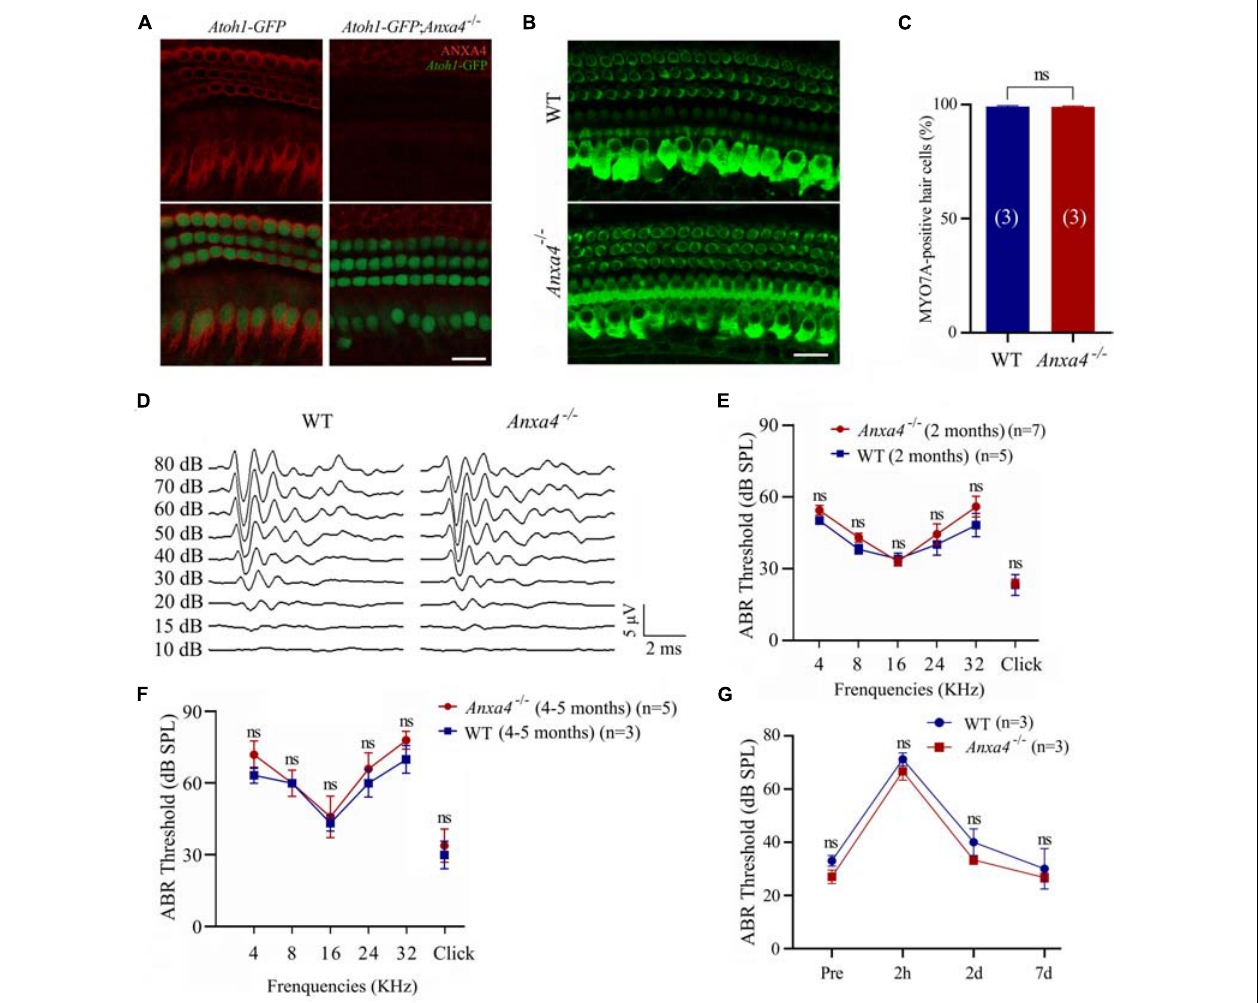
FIGURE 2 | Cochlear hair cells and auditory function are unaffected in Anxa4 − / − mice. (A) Cochlear hair cells of P7 Atoh1-GFP or Atoh1-GFP ; Anxa4 − / − mice were stained with anti-ANXA4 antibody (R&D Systems) and imaged using confocal microscope. Hair cells were labeled by nuclear GFP. (B) Cochlear hair cells of P60 wild type or Anxa4 − / − mice were stained with anti-MYO7A antibody and imaged using confocal microscope. Shown are images taken from the middle turn. (C) Numbers of MYO7A-positive hair cells from different genotypes as indicated were calculated according to the results from (B) . (D) Raw traces of ABR responses to click stimuli in 2-month-old wild type or Anxa4 − / − mice. (E) The ABR thresholds for pure tone and click stimuli in 2-month-old wild type or Anxa4 − / − mice. (F) The ABR thresholds for pure tone and click stimuli in 4–5-month-old wild type or Anxa4 − / − mice. (G) Two-month-old wild type or Anxa4 − / − mice were subjected to 2–20 kHz noise at 110 dB DSL for 2 hours, and ABR thresholds were measured pre-exposure and at different post-exposure time points as indicated. The numbers of animals used in each experiments are indicated in brackets. Scale bars, 20 µ m in (A,B) . ns, not significant.